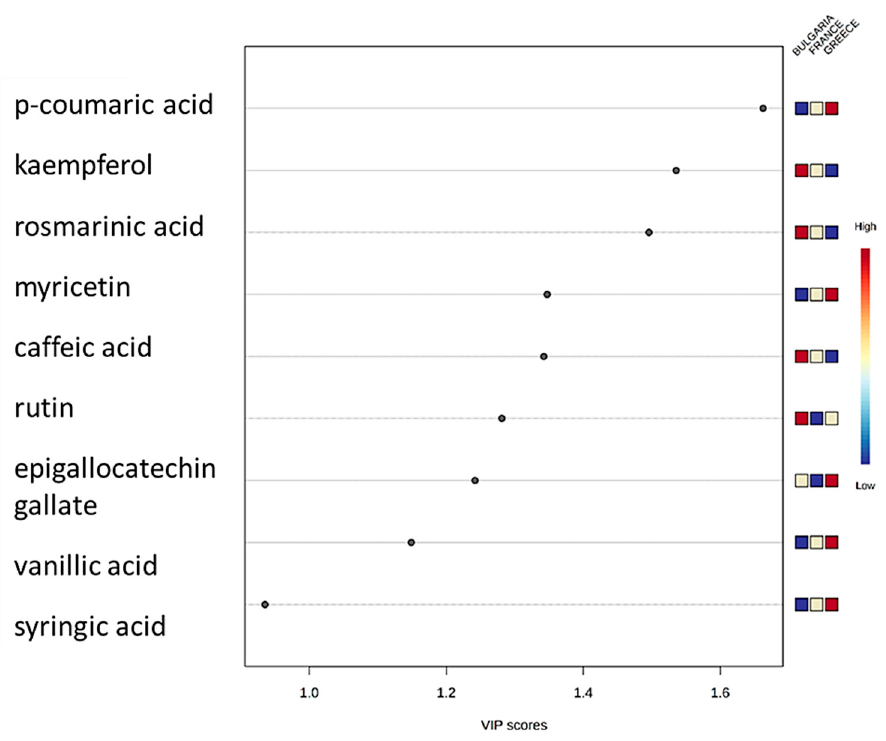
Figure 4. VIP scores of the most important features causing greater variation in the developed PLS-DA model.